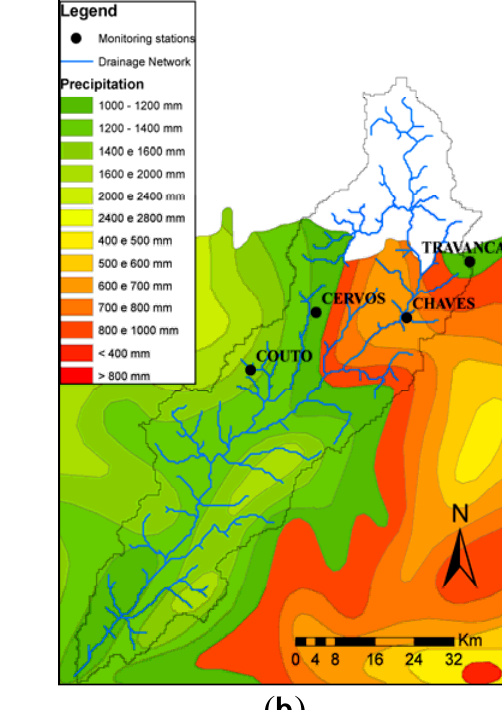
Figure 3. ( a ) Digital Terrain Model (DTM) for the Torrão watershed (Source: NASA). ( b ) Rainfall map for the watershed; dots mark the location of the monitoring stations (Source: INAG).